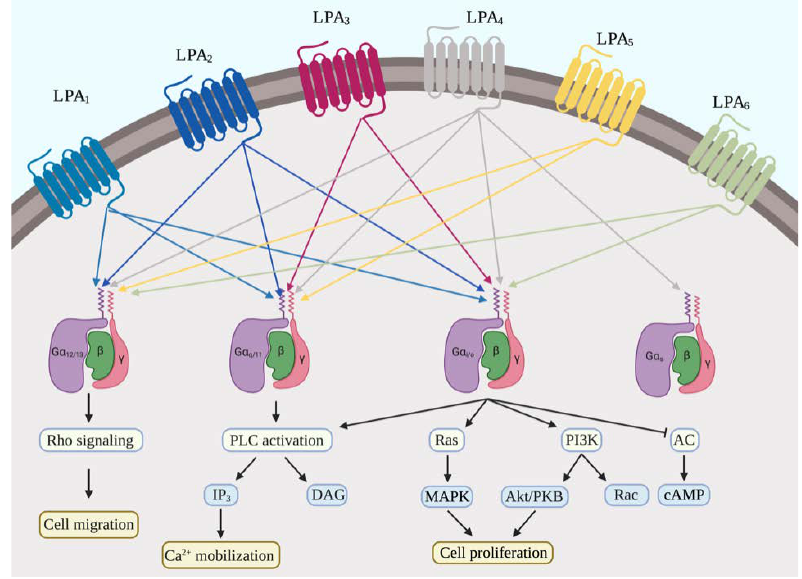
Figure 2. LPA receptor signaling. The functions of LPA are induced by the activation of 6 G-protein-coupled LPA receptors . LPA